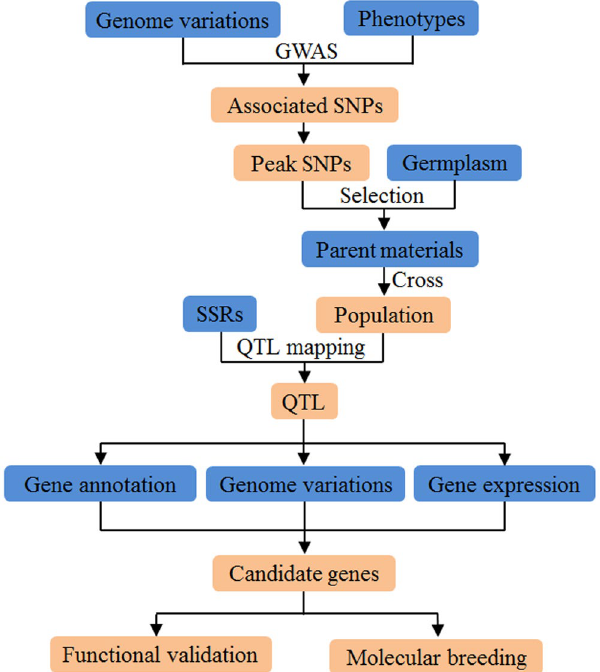
Figure 3. Flowchart of the identification of seed coat color genes from sesame with SesameFG. SesameFG provides user-friendly phenotypic and genotypic information and analysis tools for gene discovery and molecular breeding of important agronomic traits. The blue color represents the information that is available in SesameFG. The orange color indicates the analysis and experimental